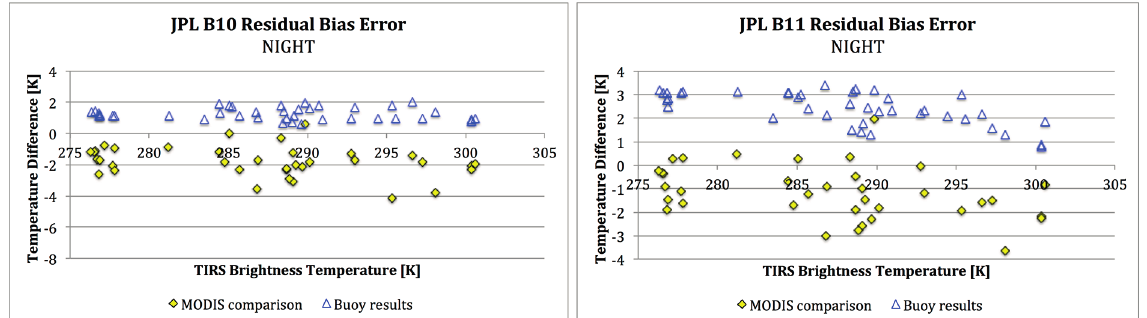
Figure 13. JPL buoy and MODIS comparison results plotted versus target brightness temperature. The trends do not overlap but they both indicate that the residual error is not dependent on target temperature. The trend in the Band 11 data is a function of the seasonal effect of the stray